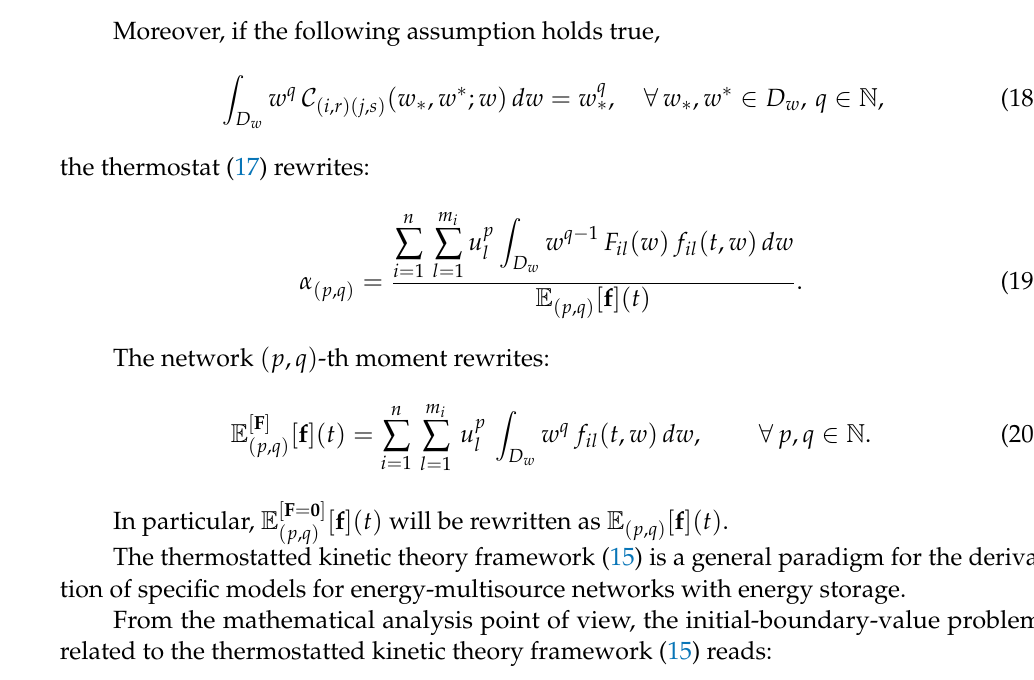
Figure 2. A network composed of different regions, each of them containing different energy sources with the storage